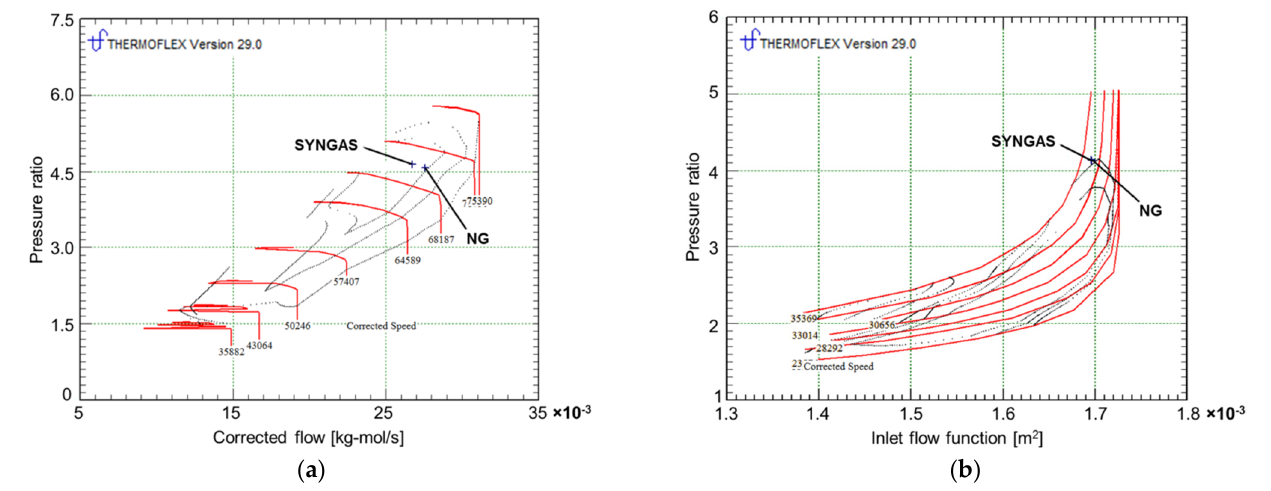
Figure 5. Effects of syngas feeding at rated speed on performance maps of: ( a ) compressor; ( b ) turbine. Table 4. Model validation with syngas feeding at the rated speed.